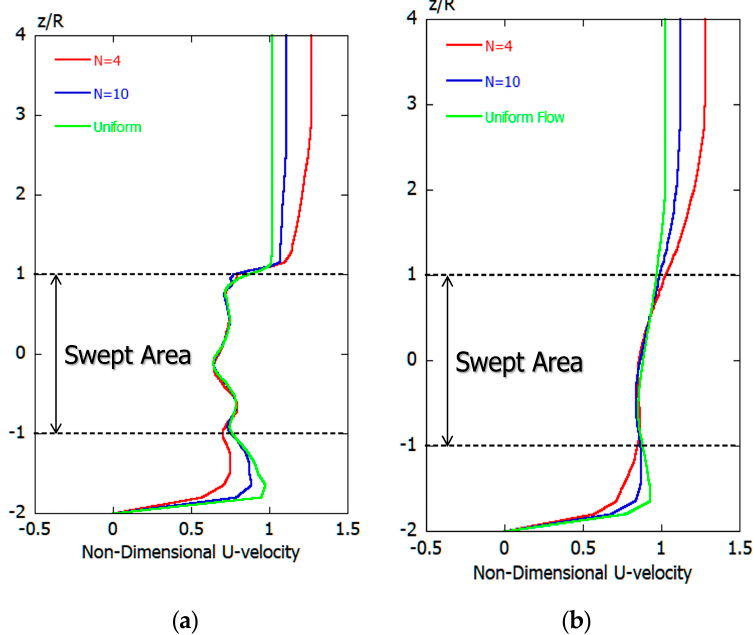
Figure 20. Comparison of vertical distribution of time-averaged U-velocity: ( a ) x = 5.0 D; ( b ) x = 30.0 D.